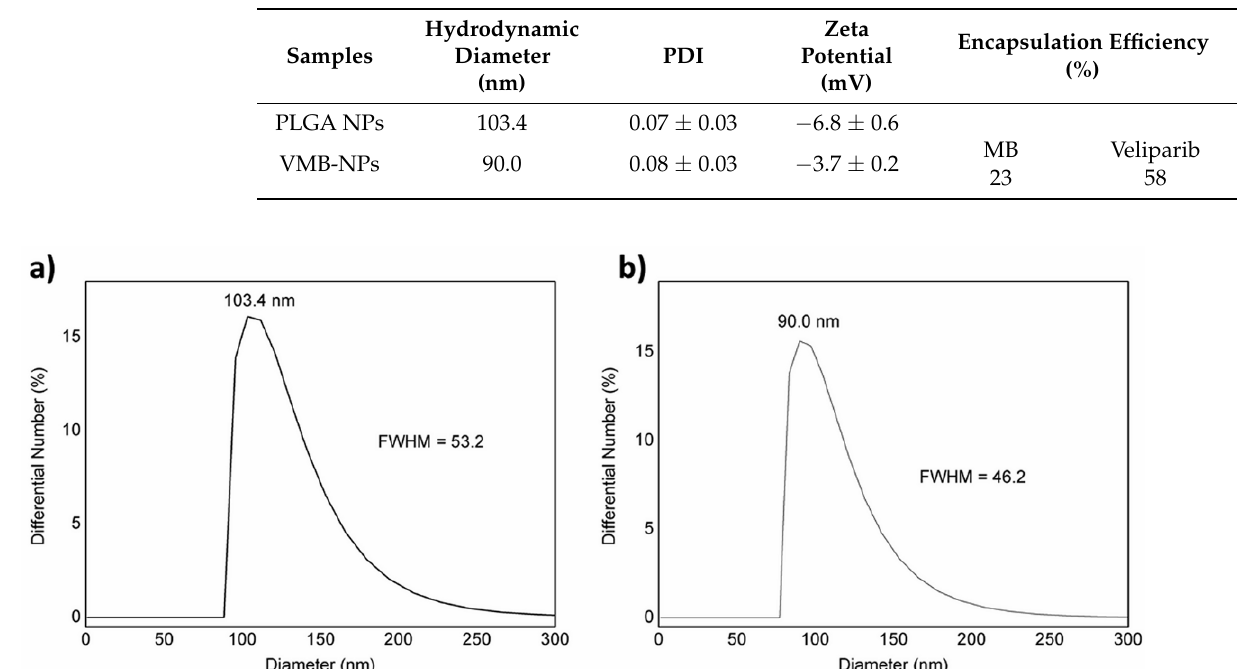
Figure 2. Size distribution of ( a ) poly(lactic-co-glycolic acid) (PLGA) NPs and ( b ) VMB-NPs.